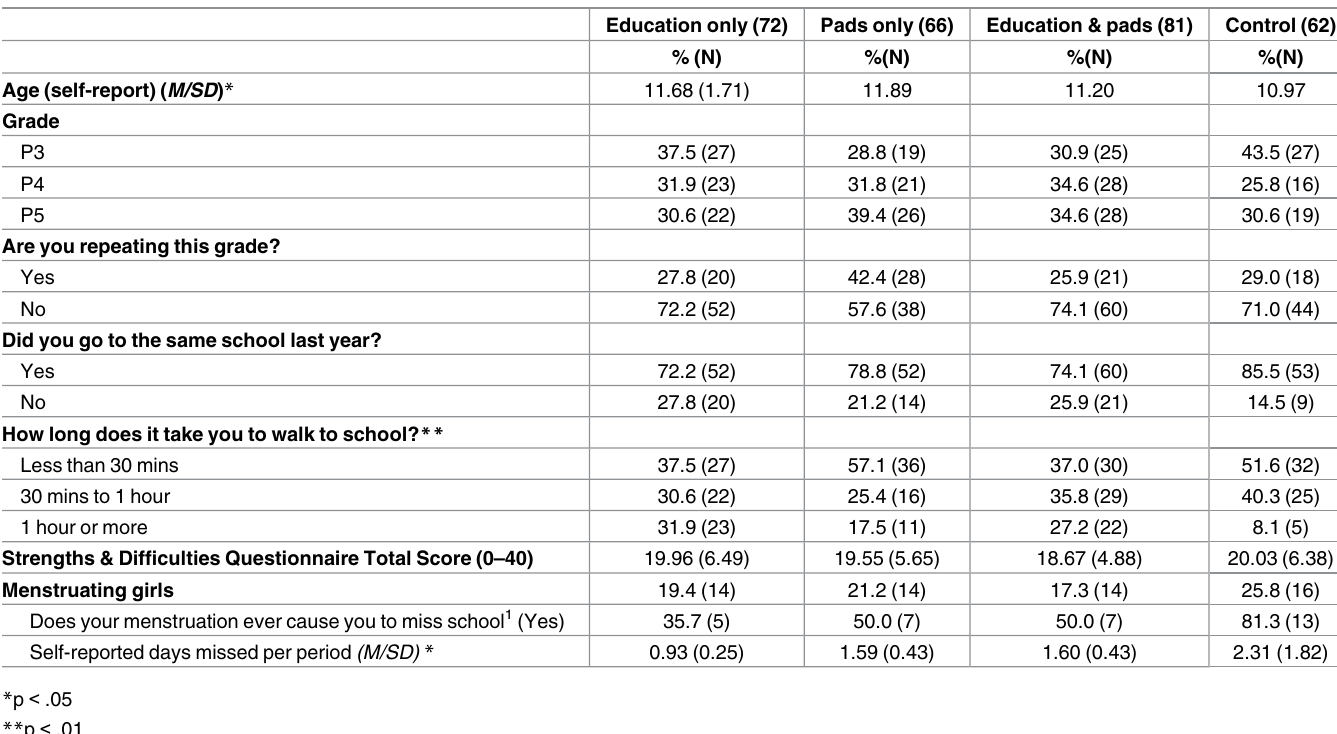
Table 2. Baseline characteristics across intervention conditions in the 25% subsample (n =